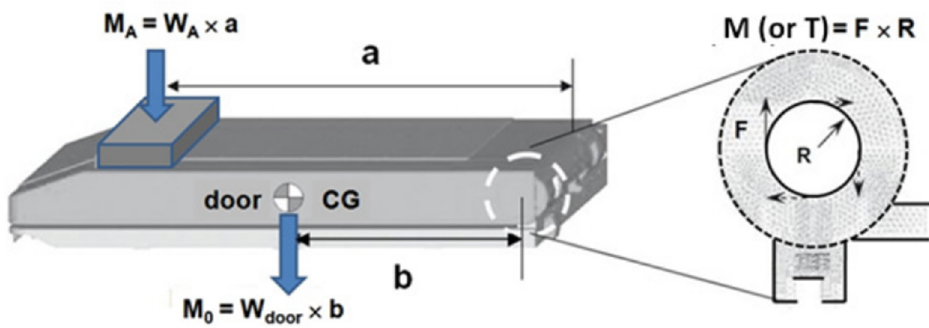
Figure 7. Functional design ideas of a mechanical HKS.